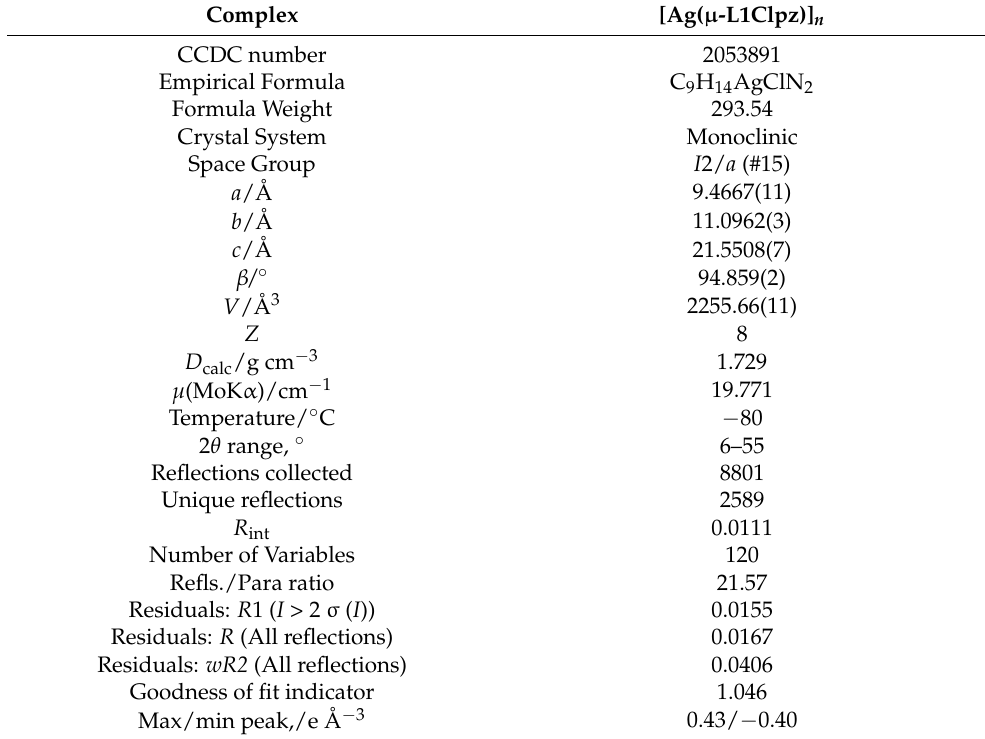
Table 1. Crystal data and structure refinement of [Ag( µ -L1Clpz)]